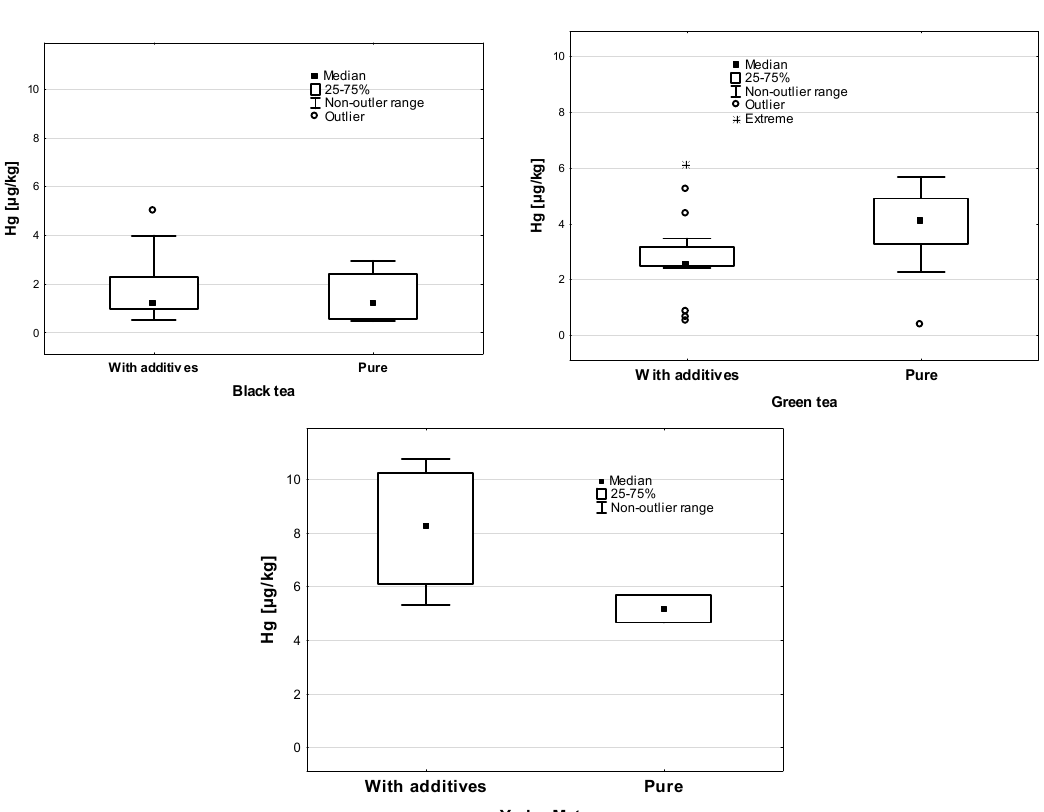
Figure 5. Hg concentration in different kinds of pure and with additives tea ( μ g/kg).